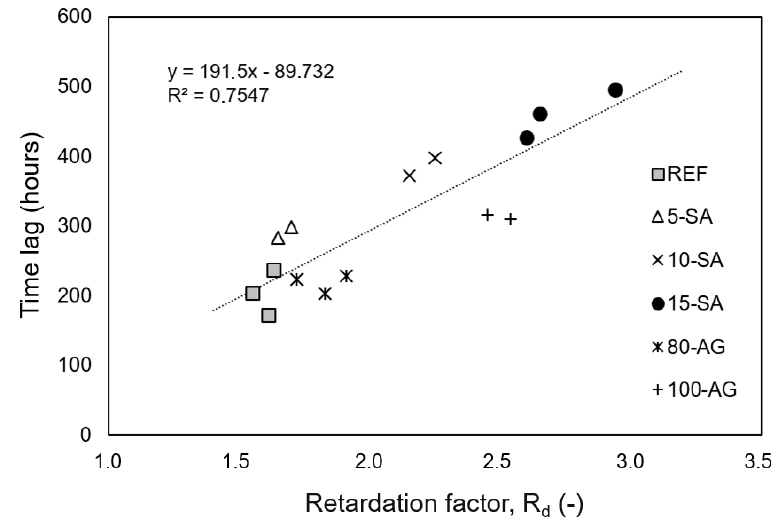
Figure 13. Correlation between time lag and retardation